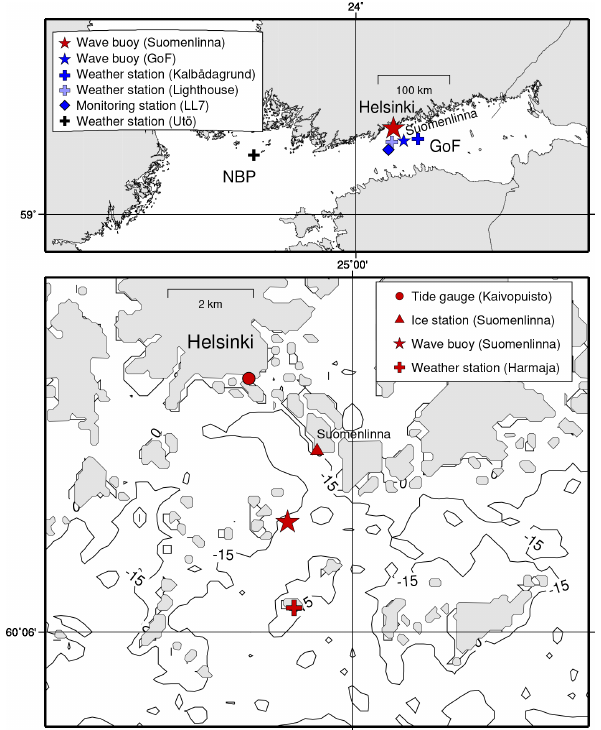
Figure 1. On top is a larger view of the study area covering the Northern Baltic Proper (NBP) and Gulf of Finland (GoF). The coastal area off Helsinki around Suomenlinna is shown on the bot- tom. The Suomenlinna ice station represents the ice conditions for a radius of about 1km. The contours show the water depth in